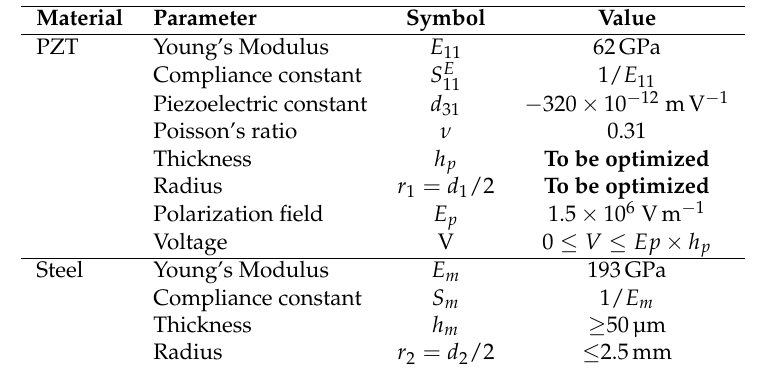
Table A1. Microactuator